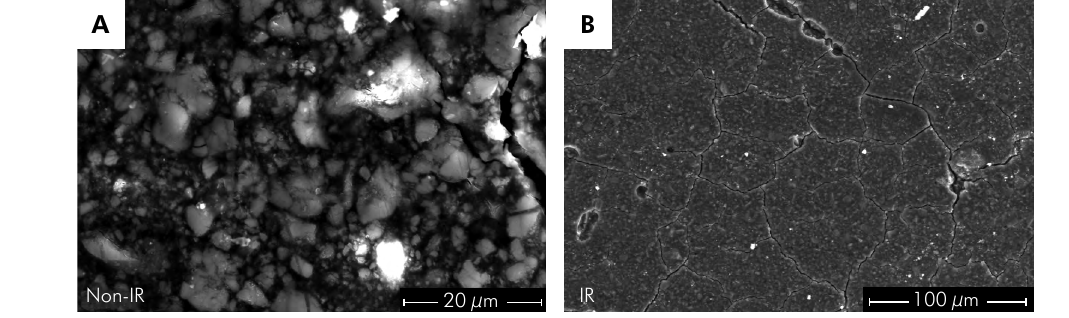
Figure 6. A: SEM photomicrograph of Zirconomer in the Non-IR (non-irradiated) subgroup. The photomicrographs were obtained with secondary electrons mode at 15 kV. Cracks were observed on the surface of the specimens; B: SEM photomicrograph of Zirconomer in the IR (irradiated) subgroup. The photomicrographs were obtained with secondary electrons mode at 15 kV. Cracks were observed on the surface of the